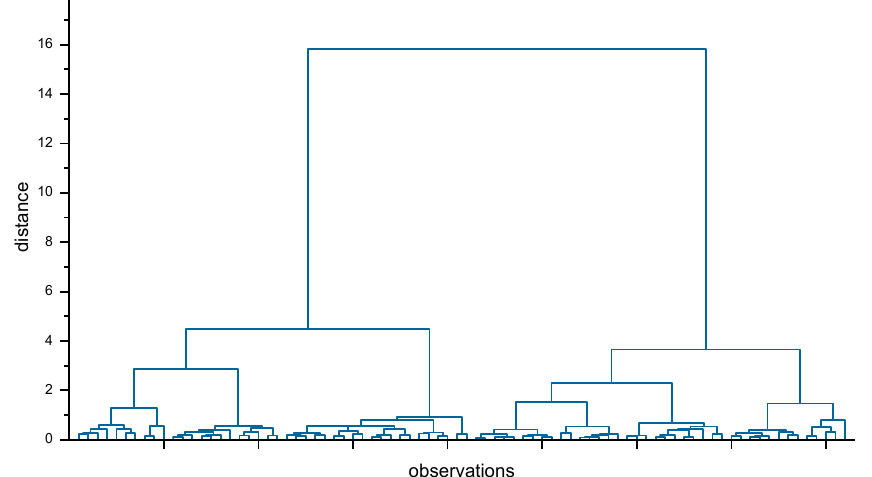
Figure 6. Dendrogram of precipitation grouping using the Ward method.